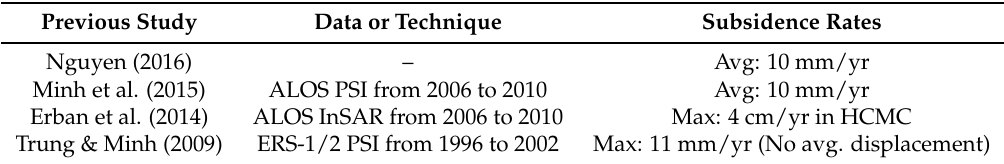
Table 1. Compilation of previous subsidence studies conducted over HCMC and their respective observations. Note that each aforementioned study leveraged LOS displacement.